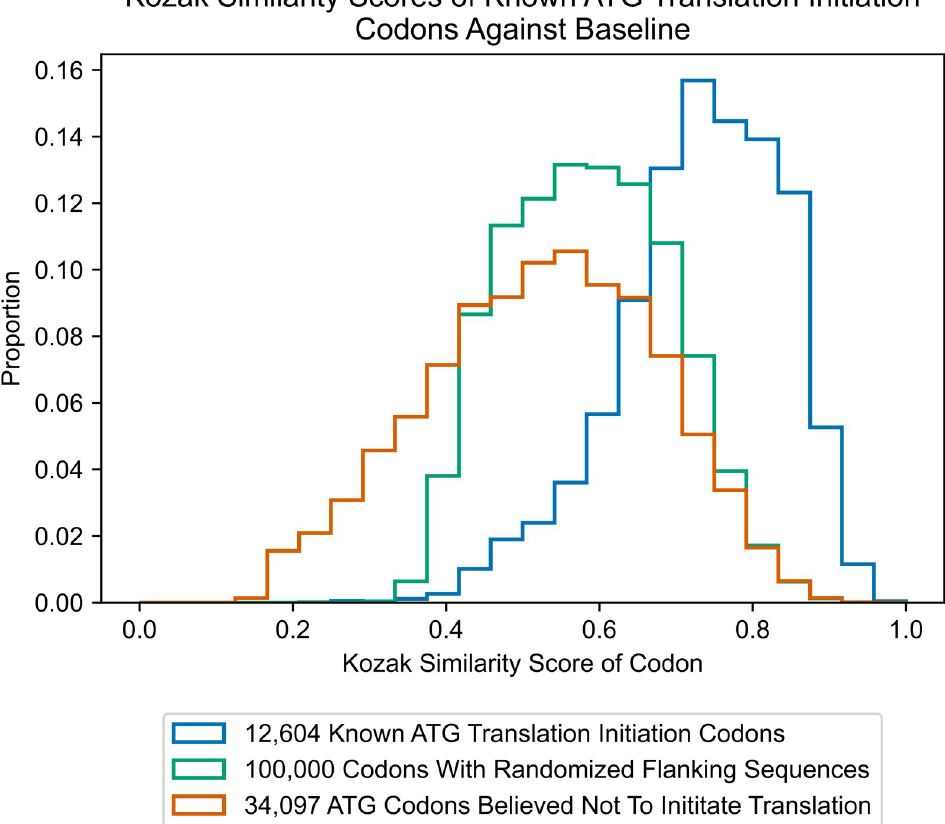
Fig 2. Kozak similarity scores of ATG translation initiation codons against